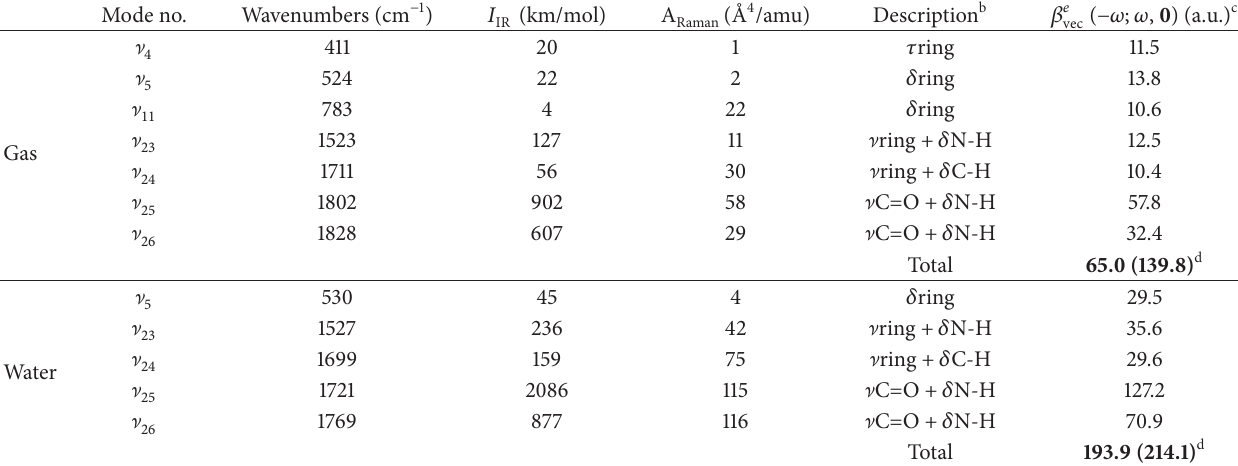
Table 2: Selected vibrational contributions to the first-order hyperpolarizabilities of uracil a . Mode no.